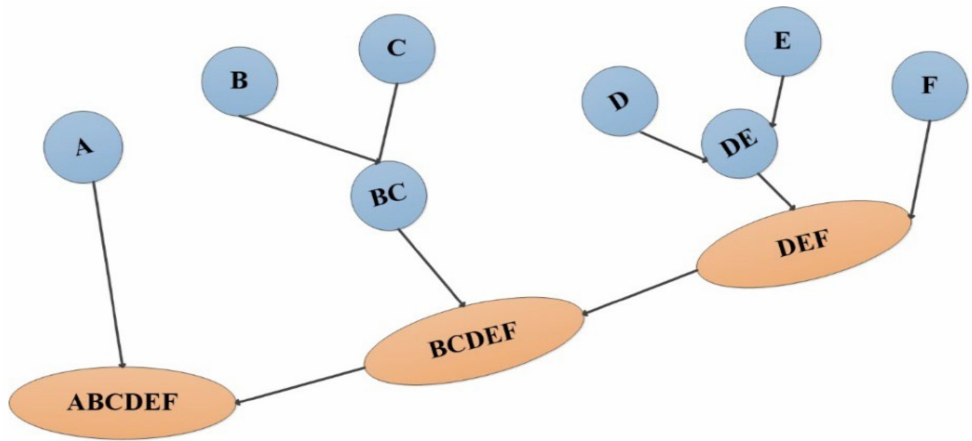
Figure 3. Agglomerative clustering